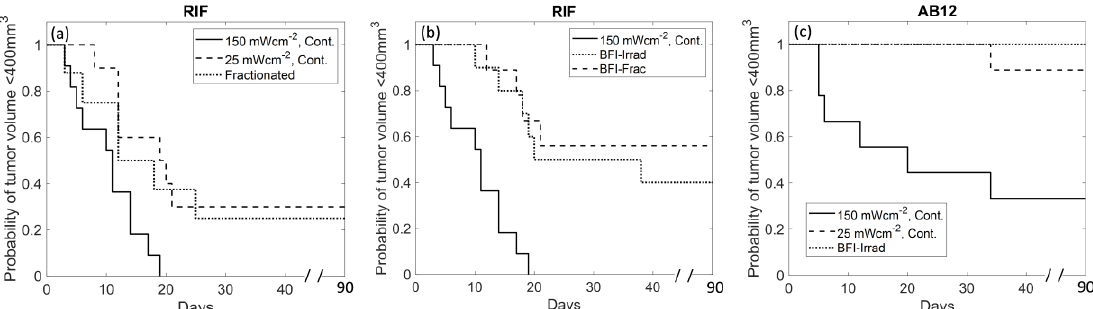
Figure 5. Kaplan Meier survival curves for radiation-induced fibrosarcoma (RIF)-bearing mice treated using ( a ) 150 mWcm − 2 -continuous, 25 mWcm − 2 -continuous, and standard 150 mWcm − 2 -fractionated illumination; ( b ) BFI-Irradiance and BFI-Fractionated illumination, and for comparison purposes, 150 mWcm − 2 -continuous is repeated as a solid line on panel b. ( c ) Kaplan Meier survival curves for murine Irradiance illumination. n = 9 – 12 mice per group. Differences in the time-to-400 mm 3 among groups